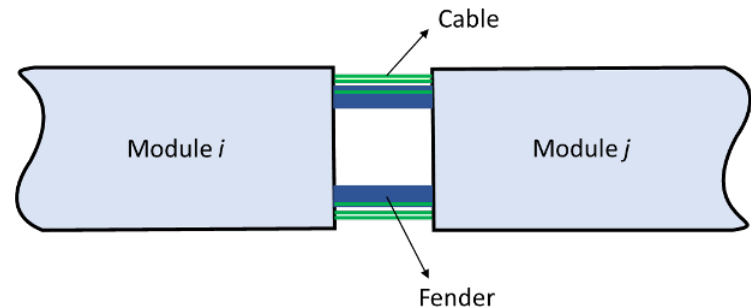
Figure 2. Simulation of RMFC model in AQWA.